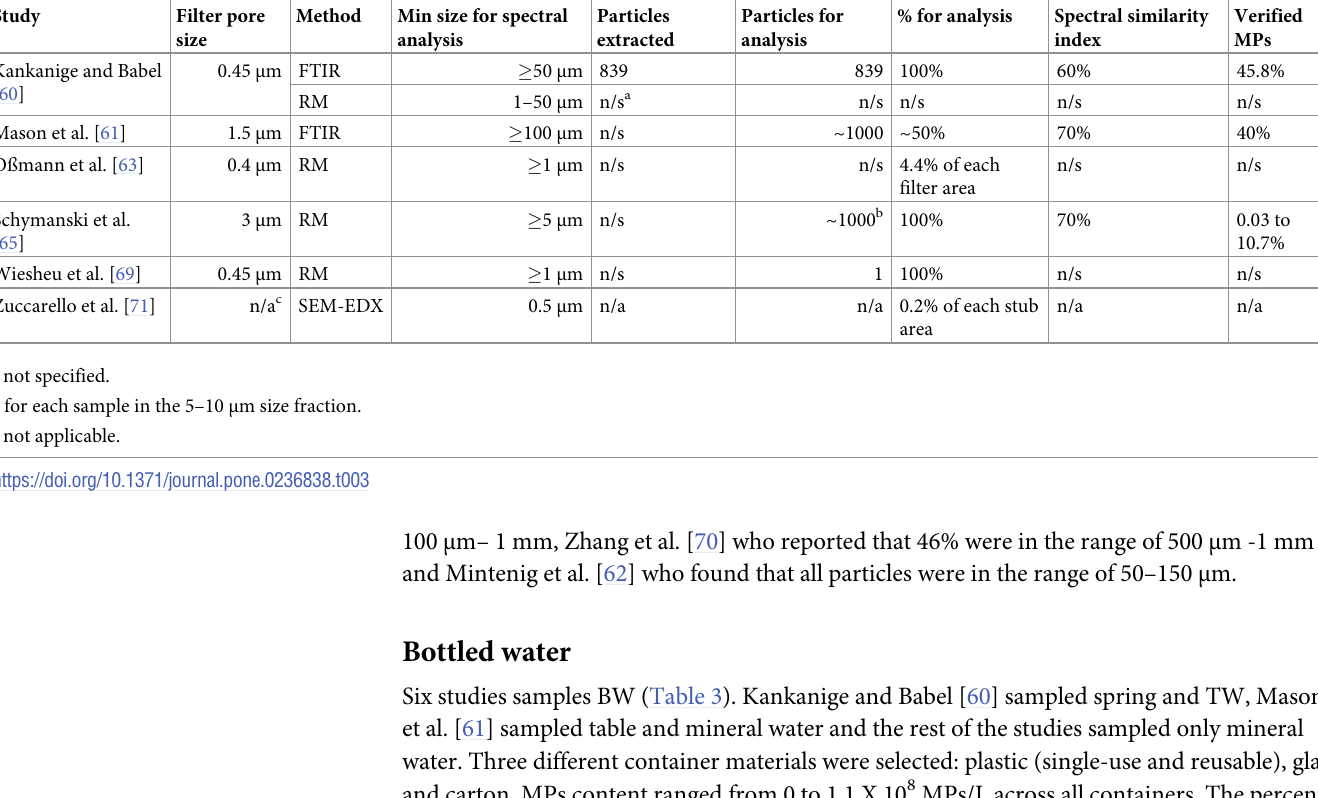
Table 3. Particle identification specifications for bottled water